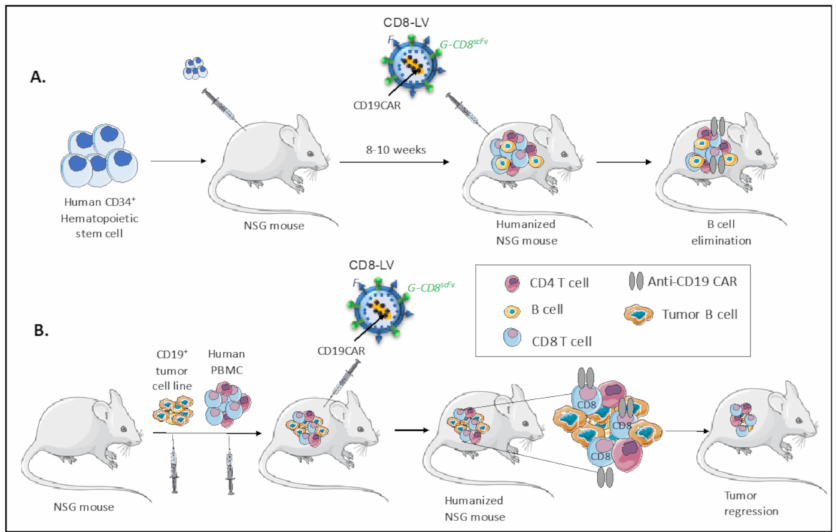
Figure 5. In vivo CAR T cell generation in humanized mice. ( A ) Cord blood CD34 + cells were injected into NSG mice and humanized for 8-10 weeks before injection of the CD8-targeted (CD8NiV)-LV encoding for a CAR-directed against CD19 present on B cells. Mice were sacrificed at 5-12 weeks for FACS analysis of the immune cells. The CAR expression was revealed exclusively in hCD8 T cells, which were amplified in vivo through contact with CD19 + B cells. Upon contact these gene-modified CD8 T cells were able to eliminate the human B cells in the di ff erent hematopoietic tissues (blood, spleen, bone marrow). ( B ) B cell line xenografted NSG mice, were subsequently infused with human PBMCs. Upon tumor formation and human immune cell reconstitution, the NSG mice were injected with CD8-targeted (CD8NiV)-LV encoding for a CAR-directed against CD19 present on tumor B cells. The CAR expression was revealed exclusively in hCD8 T cells, which were amplified in vivo through contact with CD19 + on the tumor B cells. Upon contact these gene-modified CD8 T cells were able to eliminate the tumor B